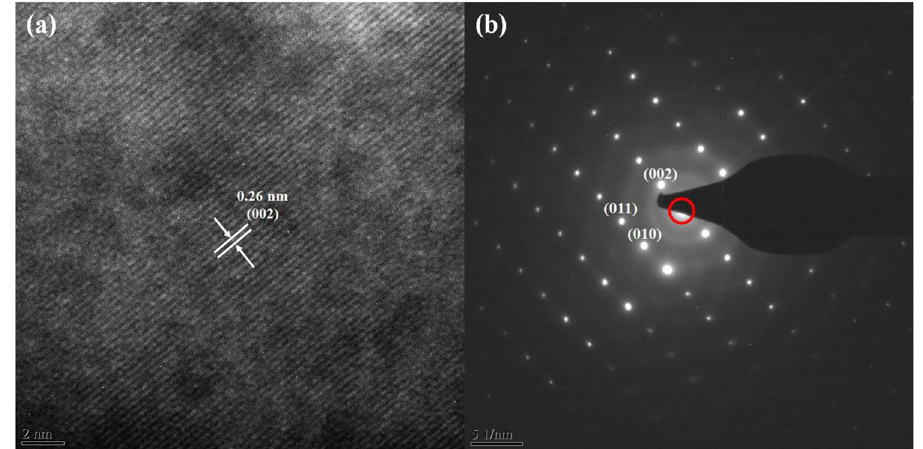
Figure 5. (a) FE-TEM images and (b) SAED patterns of sol–gel spin-coated ZnO thin films annealed by using